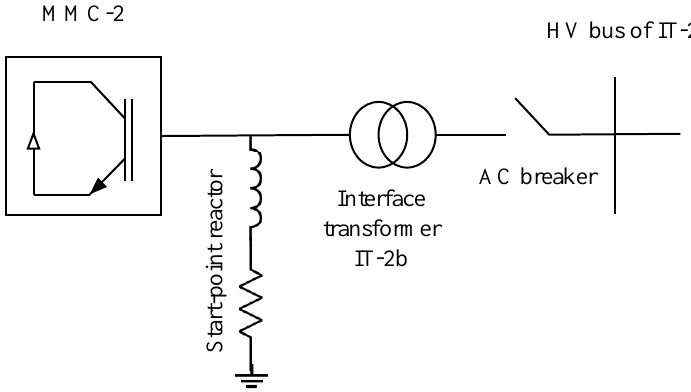
Figure 9. Representation of offshore converter station-2 connection to the AC offshore